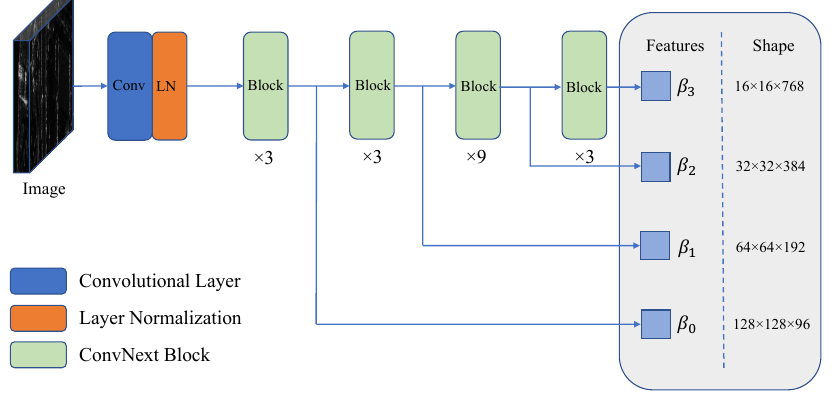
Figure 3. Feature extractor